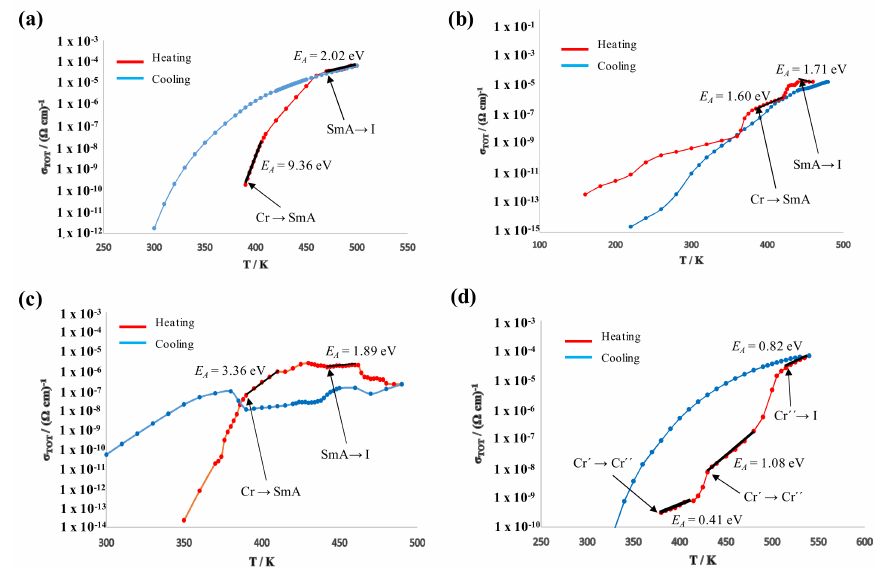
Figure 11. Representations of σ (cid:48) vs. T for the salts: BF 4 -8,8 ( a ); Cl-8,8 ( b ); Cl-12,12 ( c ); and OTf-8,8 ( d